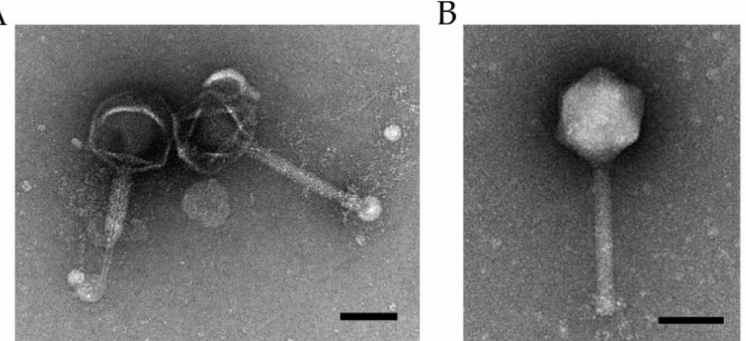
Figure 1. Transmission electron micrograph of pPa_SNUABM_DT01. ( A ) Contracted phage showing tail tube ( left ) and extended phage ( right ). ( B ) Extended phage showing clear icosahedral head morphology. Scale bars = 100 nm.